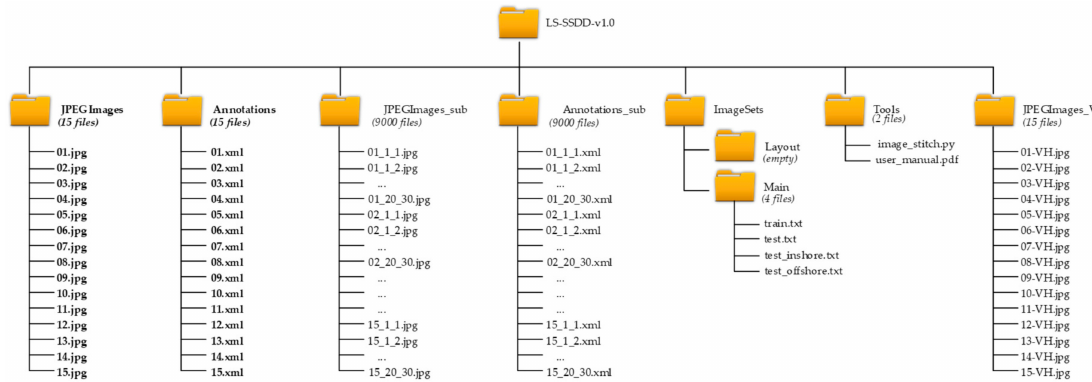
Figure 9. File content preview of